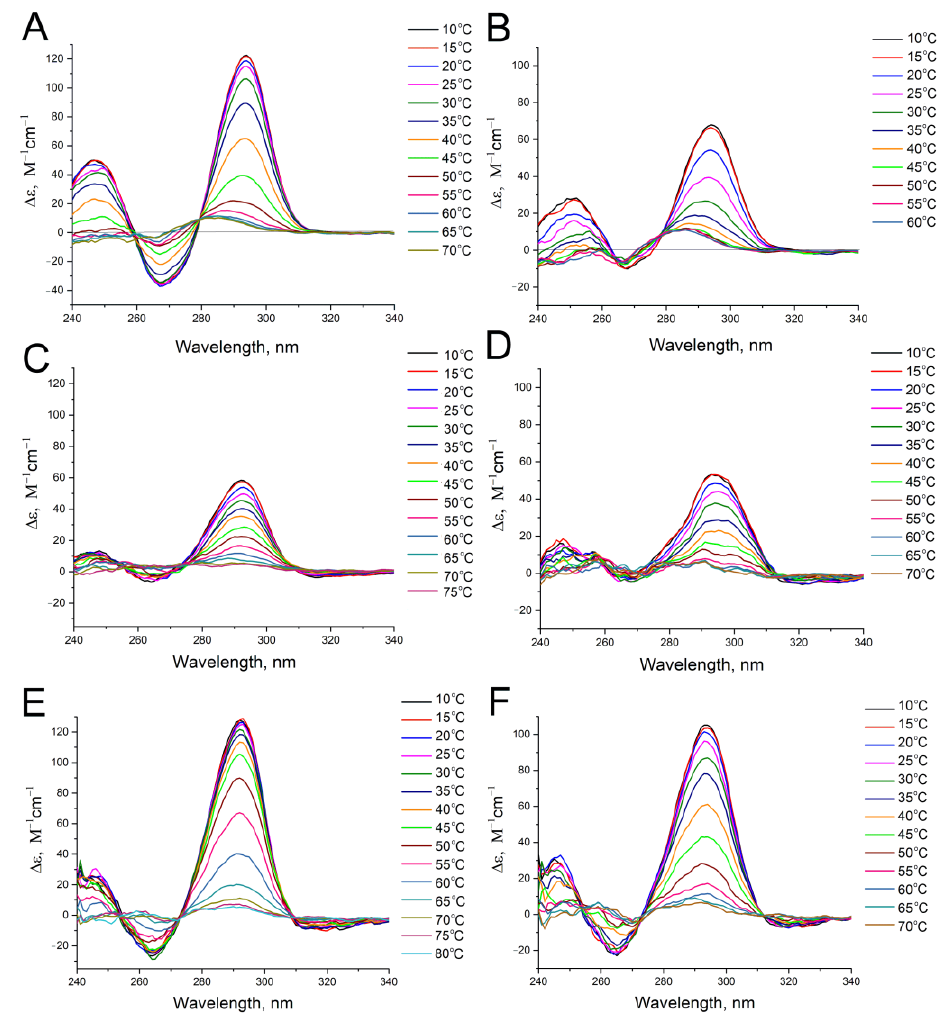
Figure 6. Circular dichroism spectra obtained at different temperatures for the aptamers: ( A ) K + - coordinated HD1; ( B ) Na + -coordinated HD1; ( C ) K + -coordinated carboxy-T4,T13-HD1; ( D ) Na + - coordinated carboxy-T4,T13-HD1; ( E ) K + -coordinated biotinylated-T4,T13-HD1; ( F ) Na + -coordinated Table 4. The structural characteristics of the aptamers in two buffer systems. The data derived from circular dichroism experiments: melting temperatures (T m ), enthalpy changes (ΔH°), entropy changes (ΔS°) , and Gibbs free energy changes (ΔG° 298 ) during G-quadruplex folding. The data for the aptamers with melting temperature increases of 10 °С and more are highlighted in green.